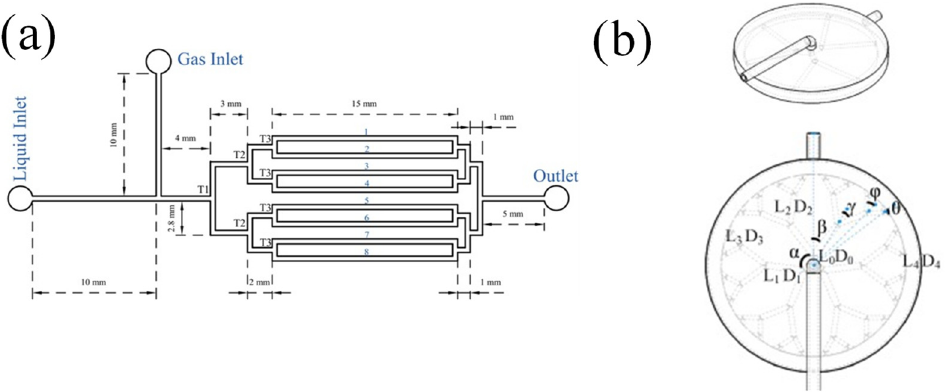
Figure 13. Schematic diagram of tree-shaped microchannel: ( a ) Guo et al. (adapted from Ref. [101]), ( b ) Lu et al. (adapted from Ref. [104]).